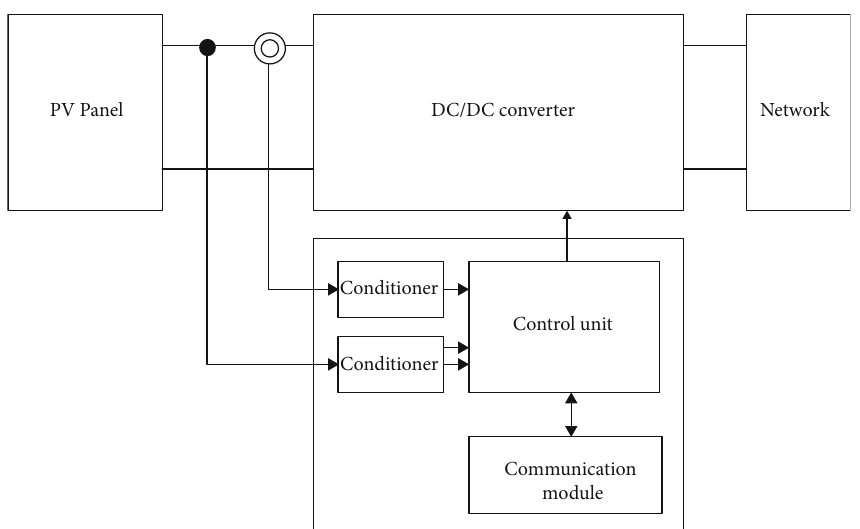
Figure 16: General structure of the converter.